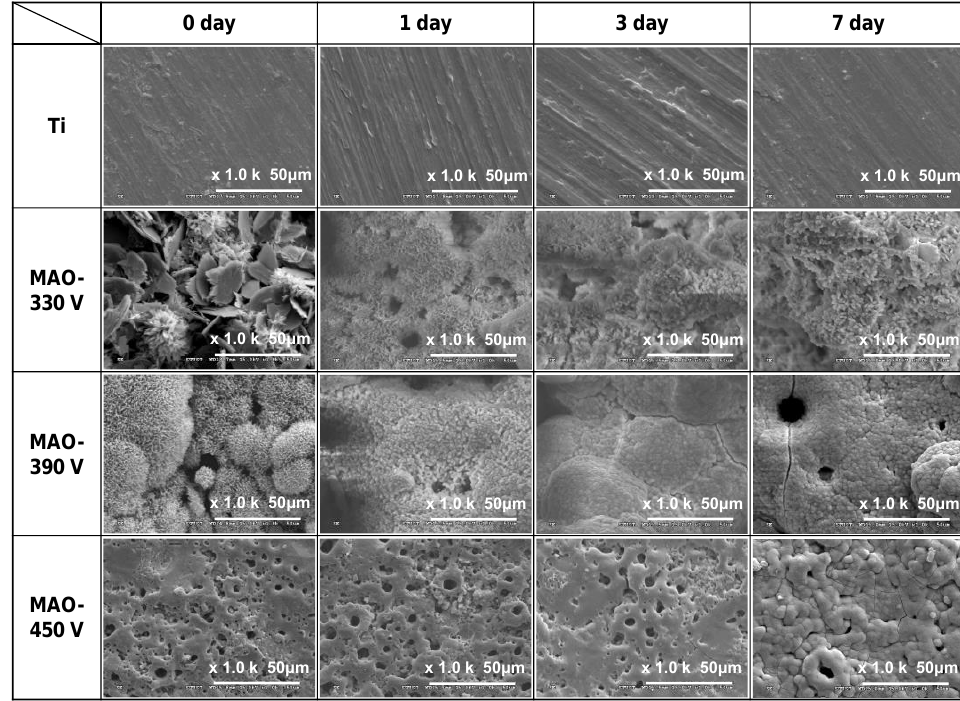
Figure 12. SEM micrographs of Ti substrate and MAO coatings prepared with different applied voltages after soaking in SBF for 1, 3, and 7 days (applied current: 0.6 A, duration time: 5 min).